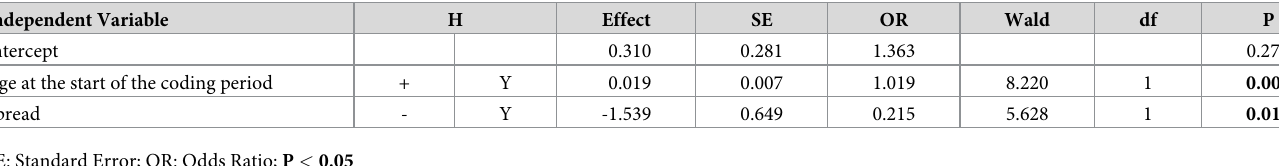
Table 10. Multivariate Poisson regression of factors associated with the number of gastrointestinal events experienced by individual elephants that experienced at least one event (n = 89). Hypotheses (H): positive (+) or negative (-) relationship of each variable with the number of clinical events per animal as a measure of elephant welfare, and whether observed relationships were in the predicted direction (Y yes / N no).